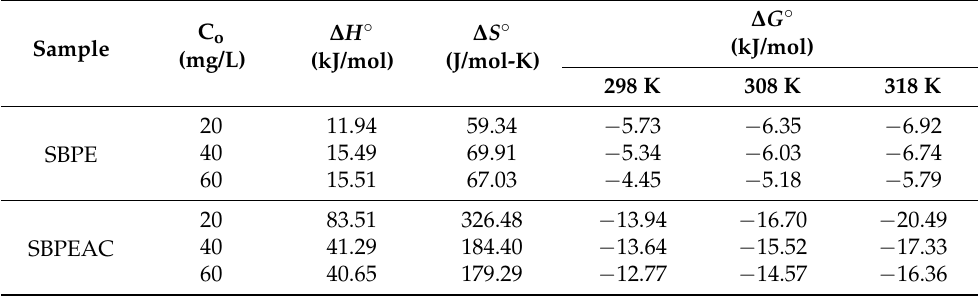
Table 4. Thermodynamic parameters for MG adsorption on adsorbent